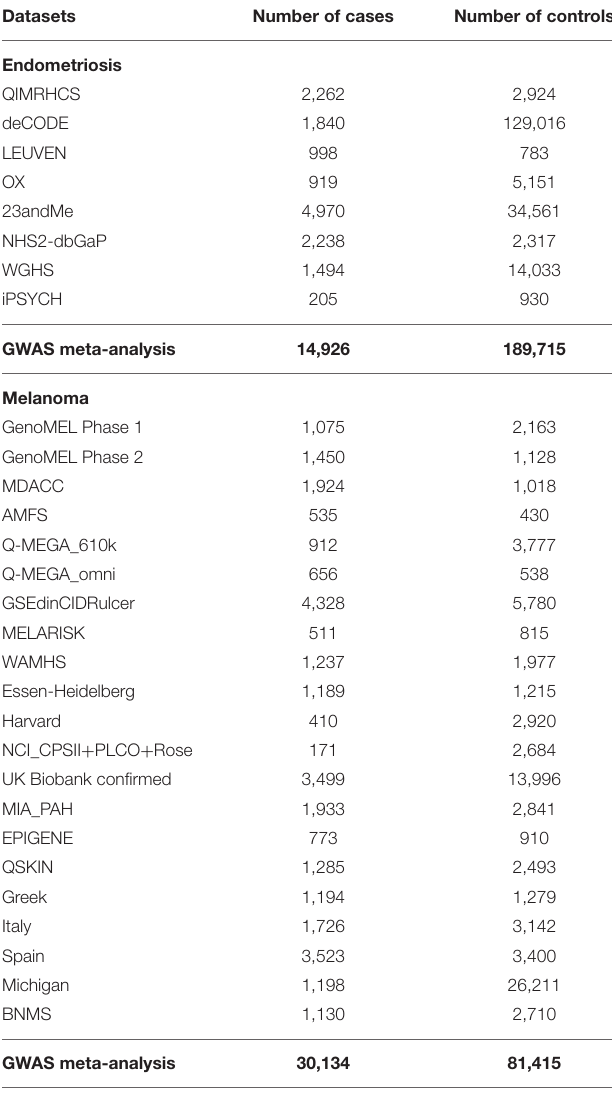
TABLE 1 | Summary of the endometriosis and melanoma case-control cohorts.